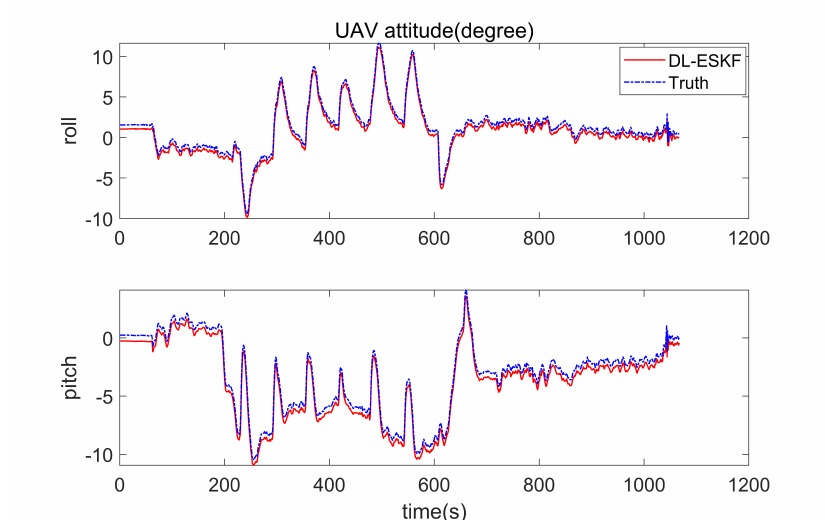
Figure 22. Autonomous flight roll angle and pitch angle.